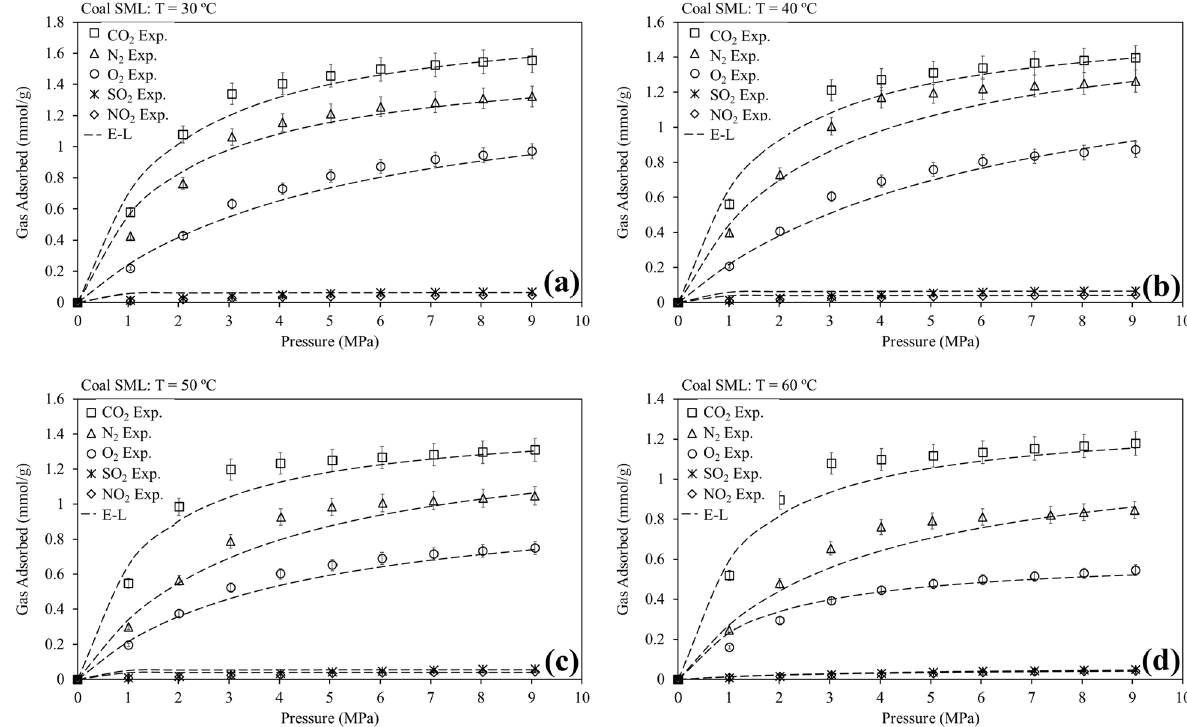
Fig. 9 Extended-Langmuir model fit for flue gas sorption on Coal SML at a 30 ºC, b 40 ºC, c 50 ºC, and d 60